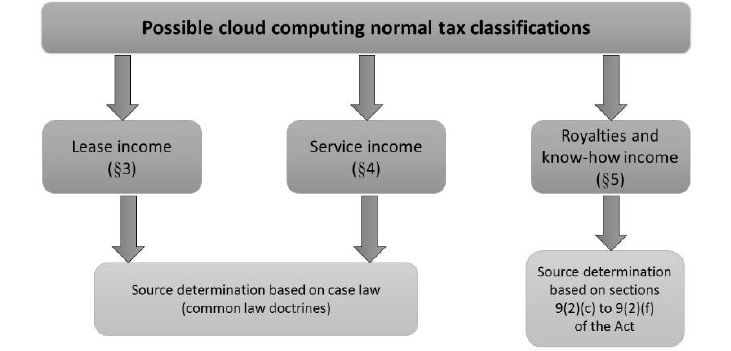
FIGURE 1: Research strategy Source: Authors’ summary of the research